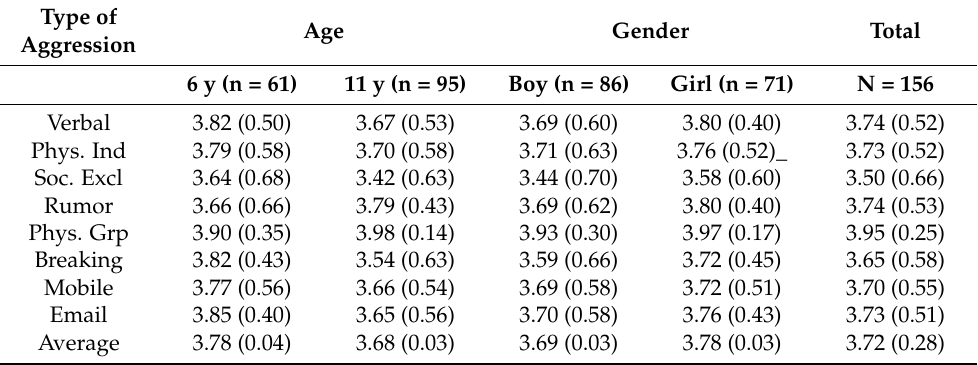
Table 4. Means (on 1–4 scale) and standard deviations for moral judgment (how wrong) by type of aggression, age, and